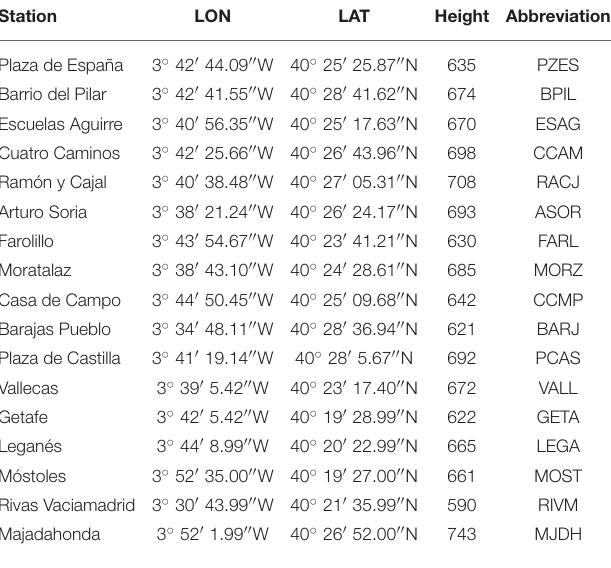
TABLE 3 | Location and description of air quality monitoring